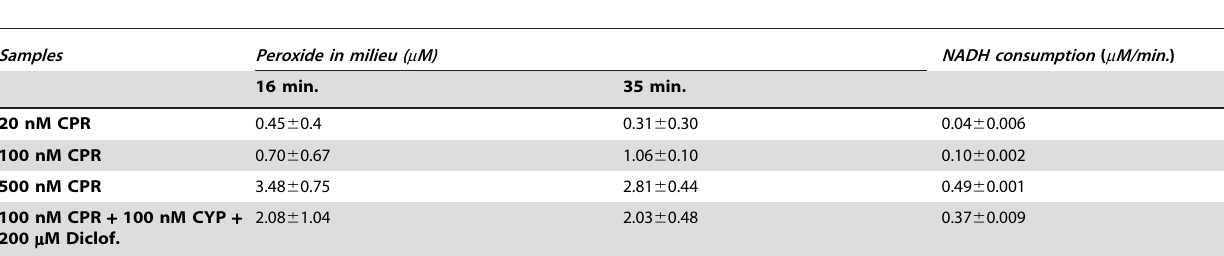
Table 2. Generation of peroxide by CPR from NADH and its correlation to depletion of NADH in a pure reconstituted system is